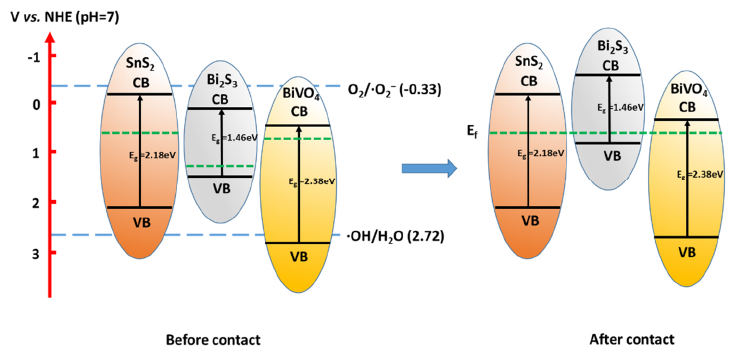
Figure 7. Band energy structures of BiVO 4 , Bi 2 S 3 , and SnS 2 before and after contact. Fermi level positions of SnS 2 , Bi 2 S 3 , and BiVO 4 with respect to their VBs (valence bands) can